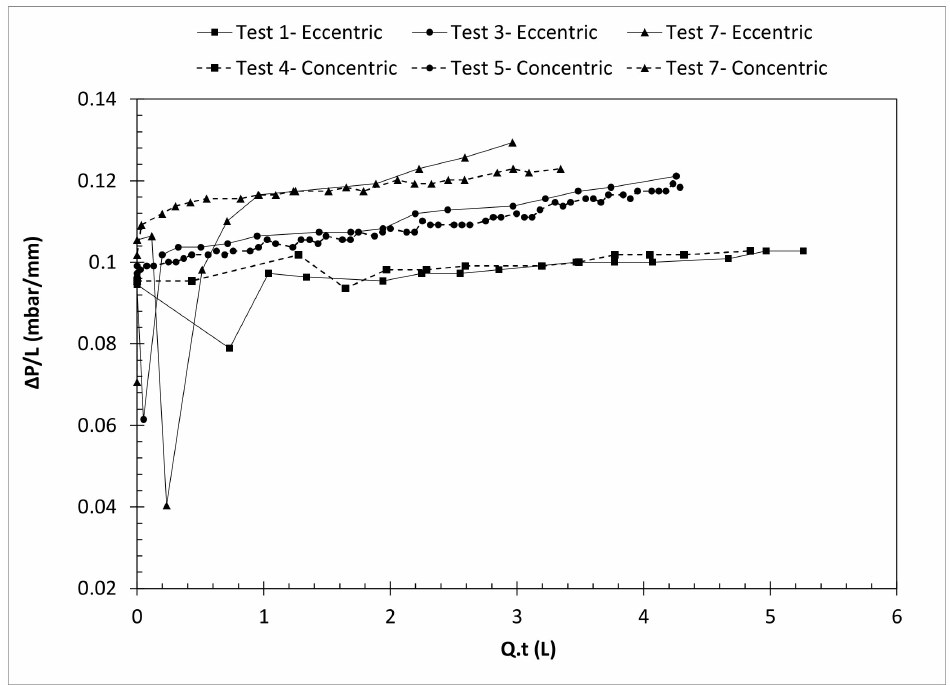
Figure 17. Comparison of pressure gradients of displacement flow tests in the cells with eccentric and concentric